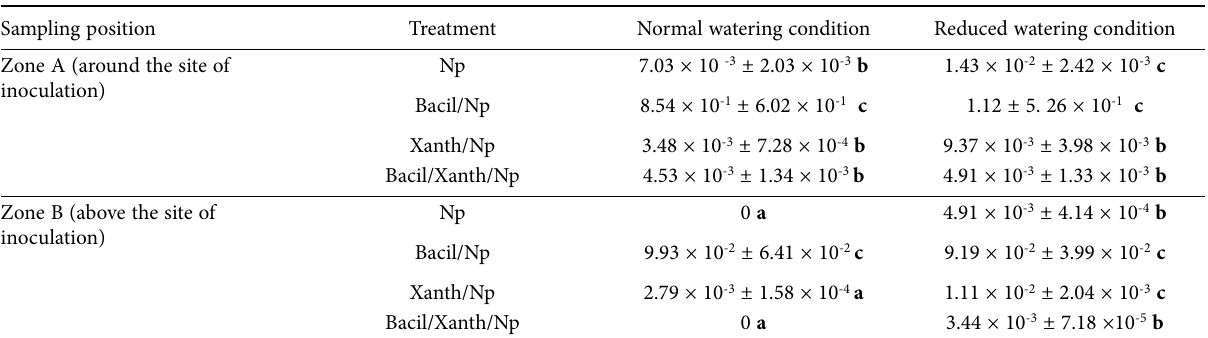
Table 1. Mean amounts (ng μL -1 ; ±SE for five repetitions) of Neofusicoccum parvum DNA, measured in grapevine cuttings 9 months after the inoculation with different microorganisms, under two watering conditions. Means accompanied by different letters indicate that differ- ences ( P < 0.05) between modalities as determined by multiple comparison analyses (Kruskal-Wallis). Np: Neofusicoccum parvum, Bacill: B. pumilus (S35), Xanth: Xanthomonas sp.